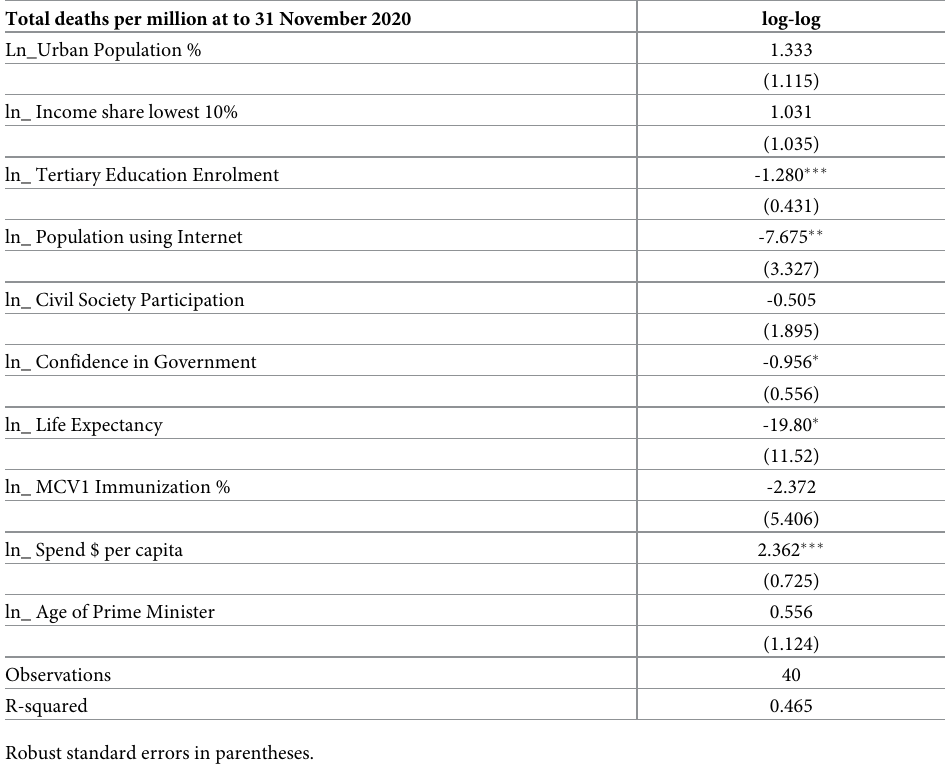
Table 8. Multivariate calculation of ten representative